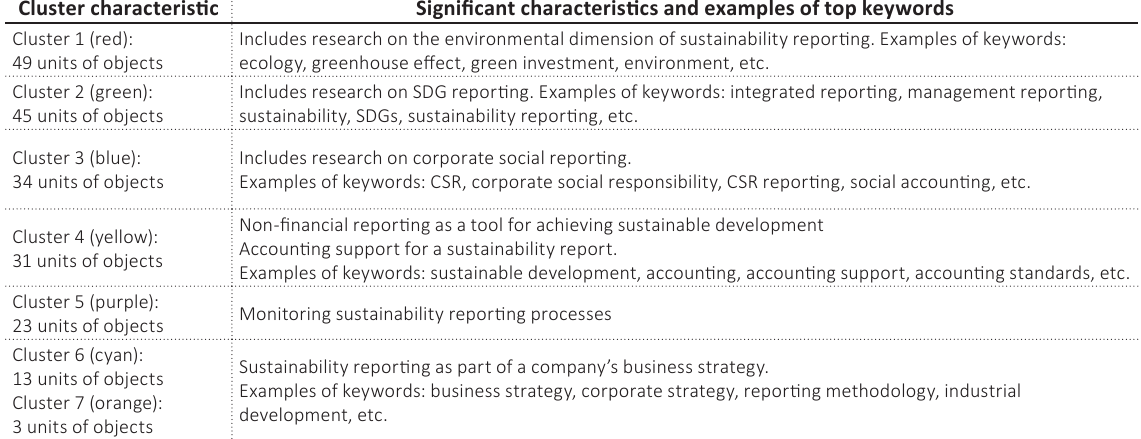
Table 1. Characterization of bibliographic clusters based on the analysis of interconnection identification using VOSviewer Cluster